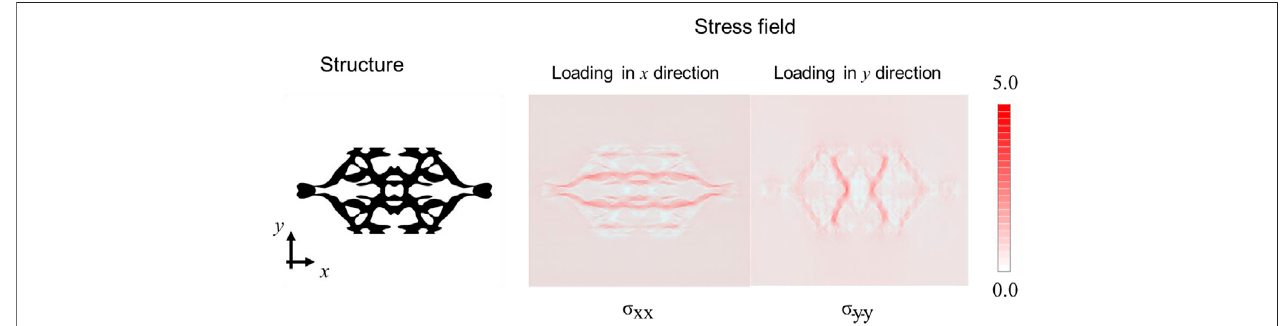
FIGURE 10 | Stress fi elds (in MPa) of the structure proposed in Figure 8 predicted by cGAN approach (Yang et al., 2021a). Two different loading conditions (uniaxialtensiontestin x and y directions,respectively,areshown).Inthetensiletestalong x direction,thepredictedstress fi eldis σ xx whileinthetestalong y direction,the stress is σ yy . As shown by the stress fi elds, the anisotropy of the structure lies in different load-bearing parts when the loading is exerted in different directions. In the uniaxial tension test along the x direction, the two continuous horizontal lines take the most load while loading along the y direction, the vertical X-shape parts have higher stress concentration. The mechanisms are similar to the that in Figure 5 as the continuous regions aligned with the loading direction are most signi fi cant in terms of load-bearing.